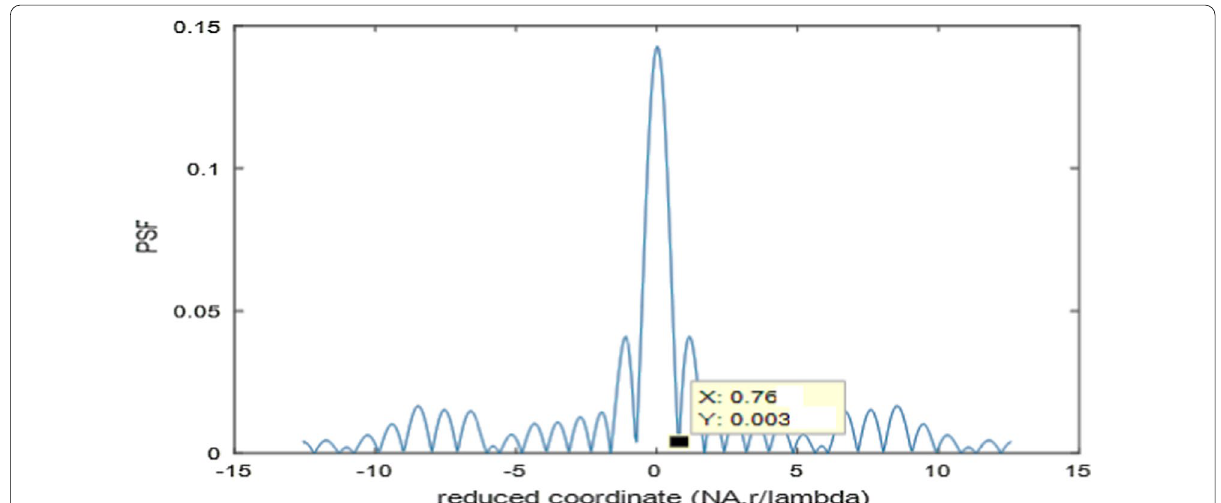
Fig. 8 Normalized PSF for the second model of polynomial aperture using FFT technique. The total diameter frequency is located at W cut-off =